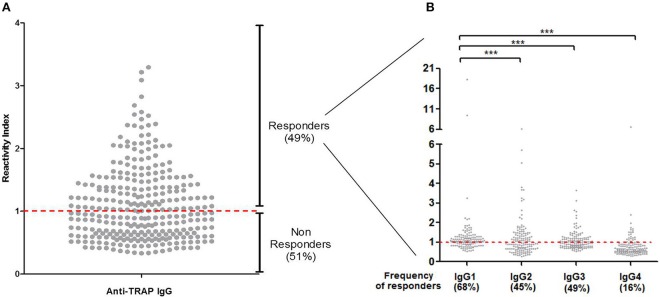
(A) Frequency of responders and reactivity indices of specific IgG antibodies. The red line represents the cutoff reactivity index (RI) value that was considered to classify individuals as positive (>1) and negative (<1) for PvTRAP. (B) Profile of IgG subclasses in responder individuals for PvTRAP. ***p < 0.0001.